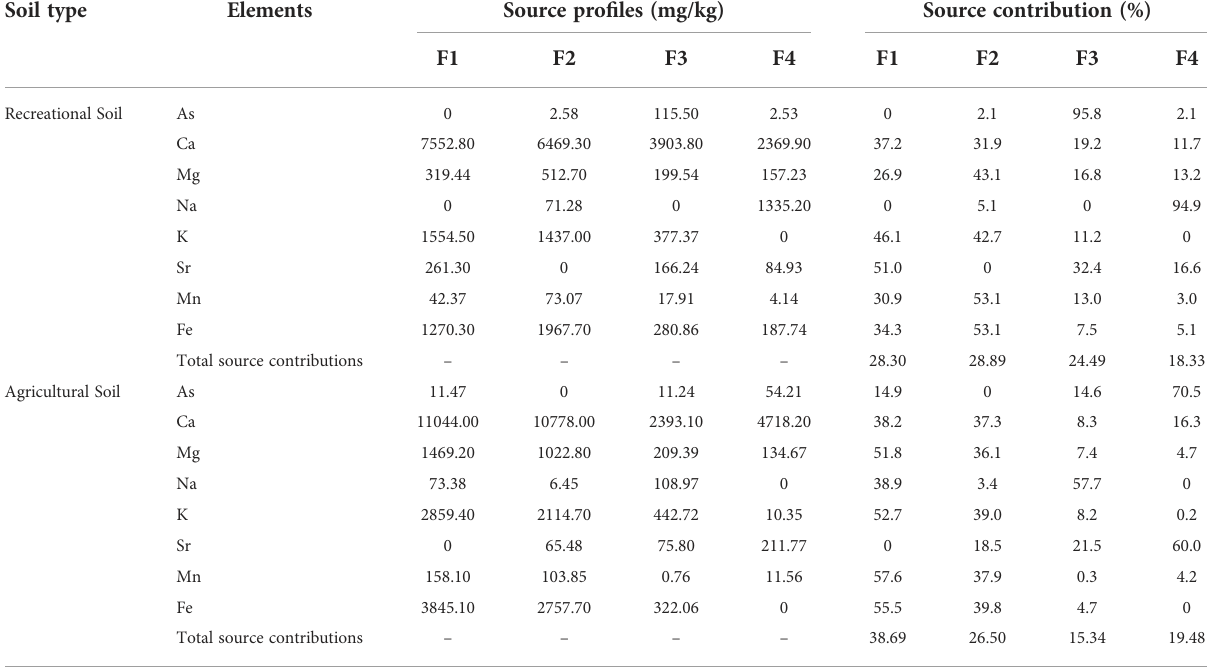
TABLE 4 Source contribution rates of factors for metal concentrations in the soil.